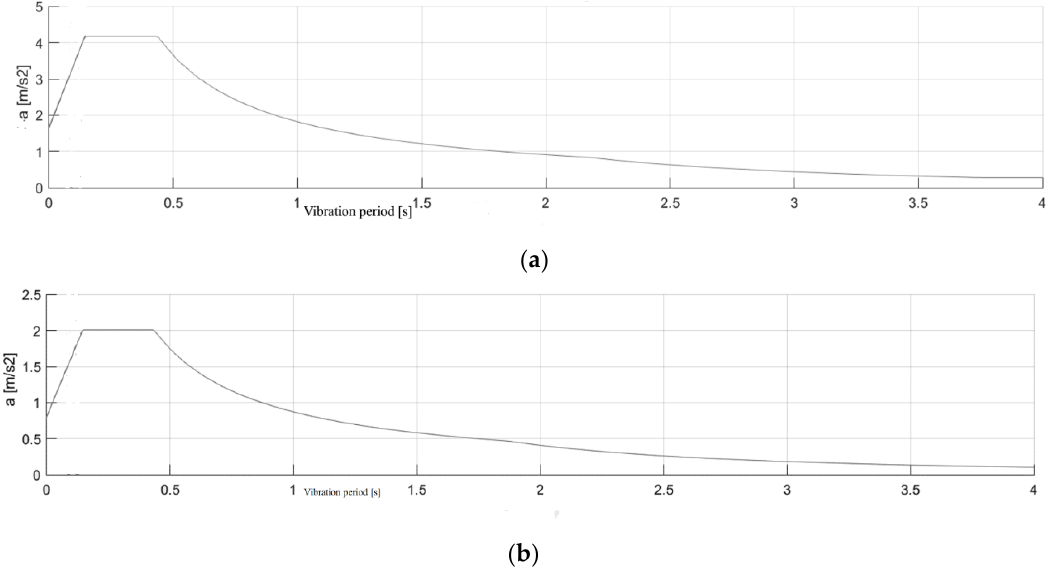
Figure 22. ( a ) Acceleration spectrum for seismic action 1; ( b ) acceleration spectrum for seismic action 2.